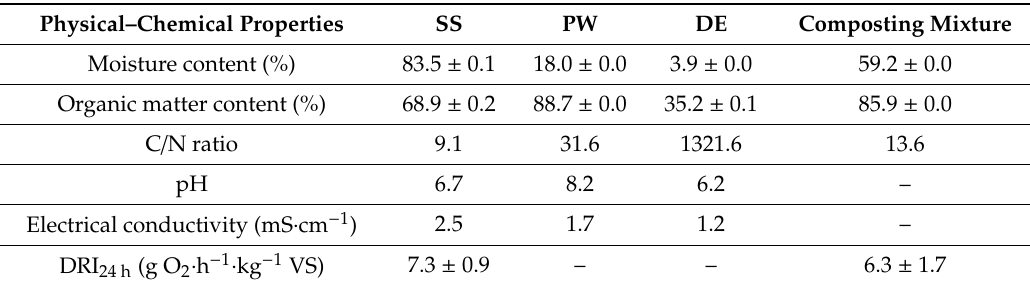
Table 1. Physical–chemical properties of the feedstocks and mixture used during the sewage sludge (SS) composting